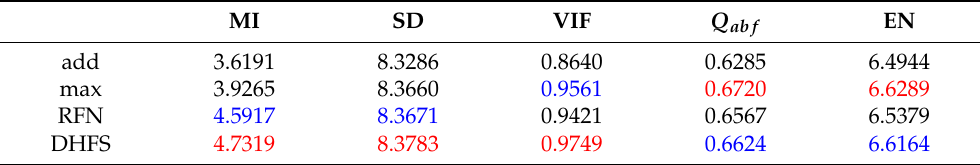
Table 6. The results of ablation study for the DHFS on the 361 MSRS dataset. The red value indicates the best result and the blue value indicates the second-best result.